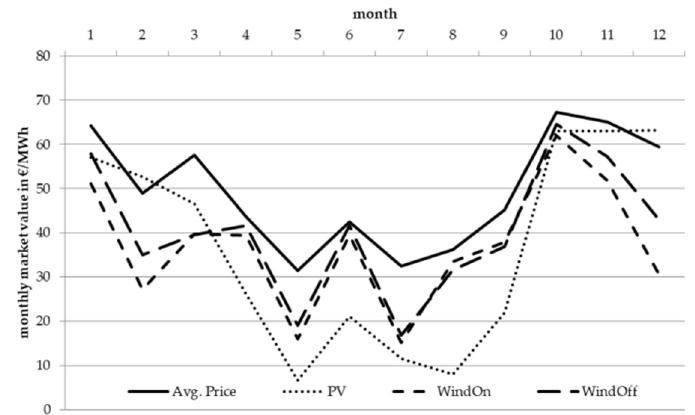
Figure A5. Market prices for one year in the extended storage scenario.